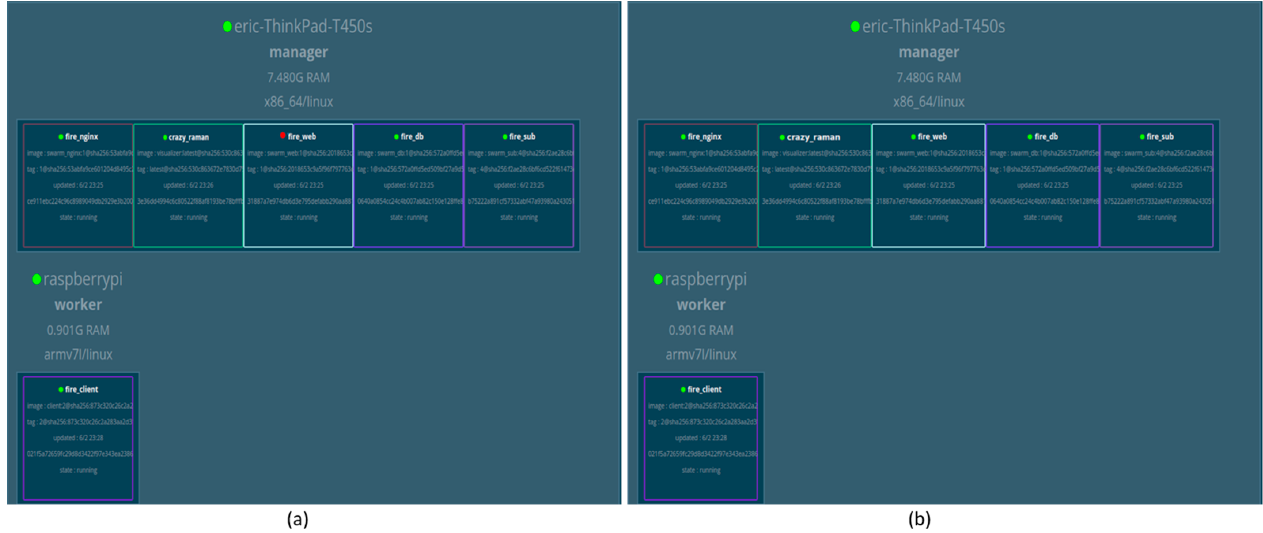
Figure 11. ( a ) Visualization of container clusters with one non-working container service with the attached RPi worker. ( b ) Visualization after system container stabilization.